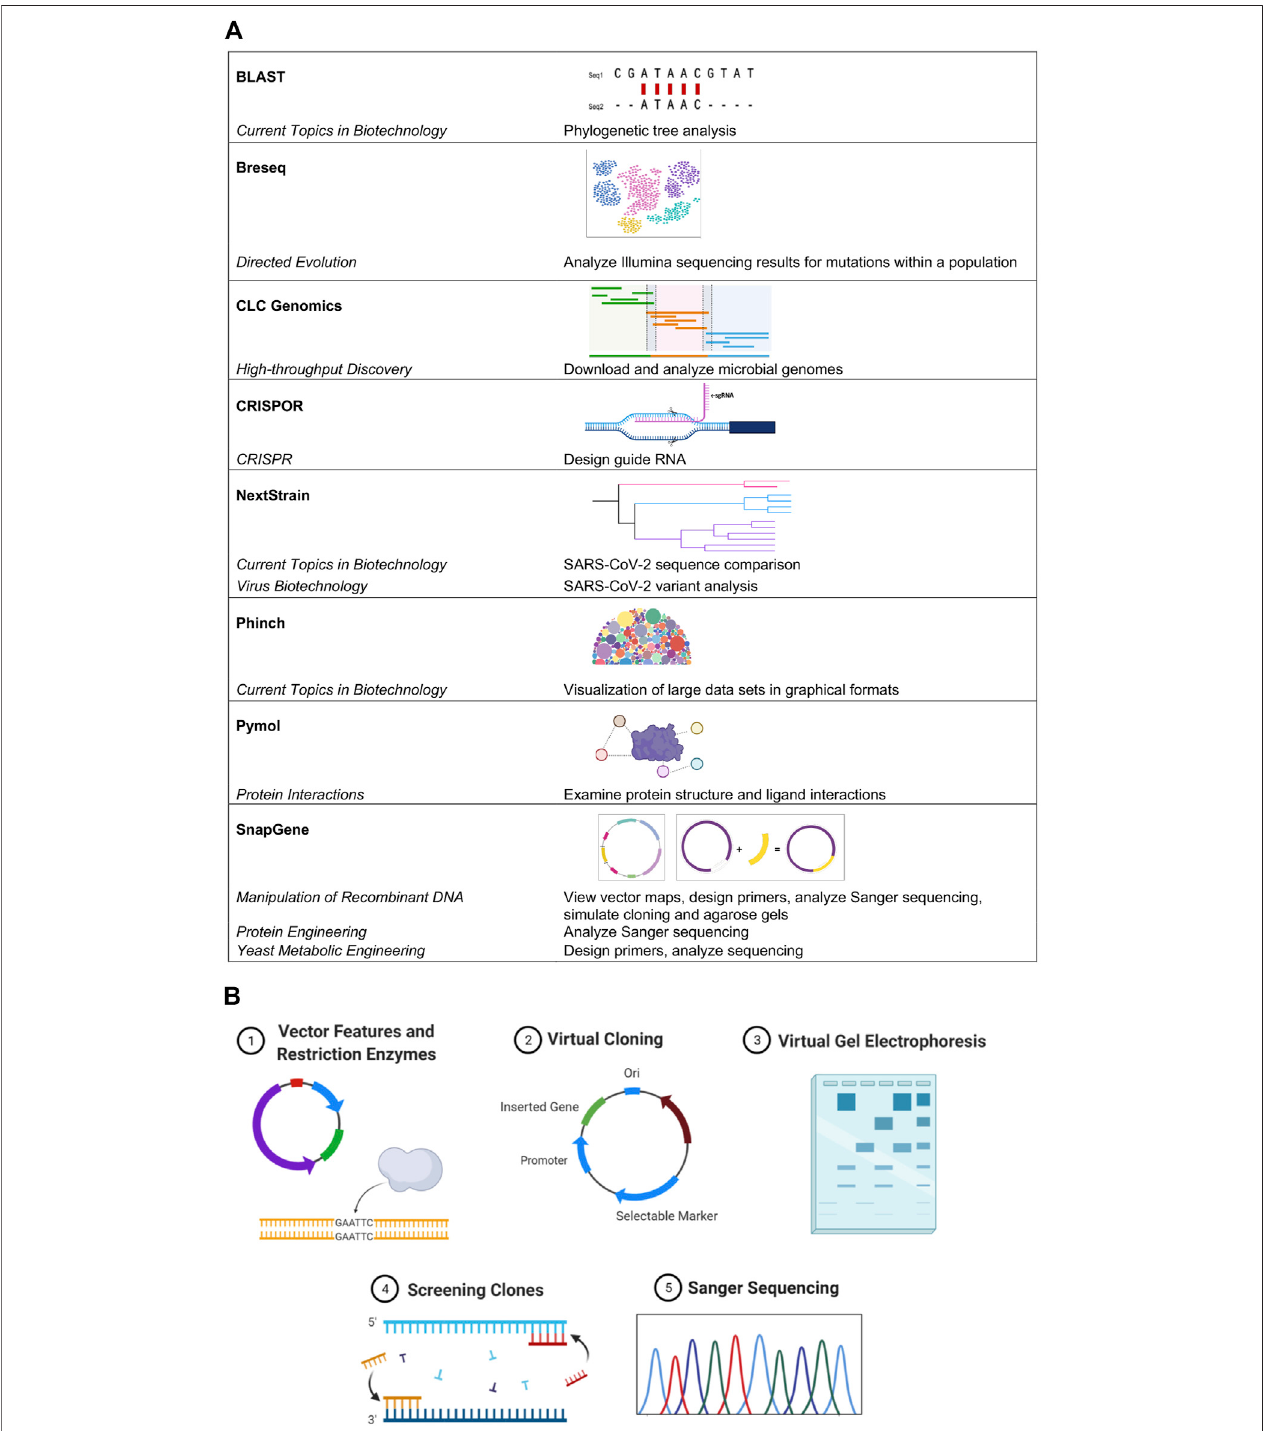
FIGURE 1 | Bioinformatics usage across MBLEMs. (A) Examples of bioinformatics software used in MBLEMs. (B) Student-driven in silico cloning projects challenge individualsto practice using bioinformatics software to solvetasks they would encounter in molecular biology. Key aspects ofthe project design areillustrated including: vector features and restriction enzymes, virtual cloning, virtual gel electrophoresis, screening, and Sanger sequencing. Images created with BioRender.com.